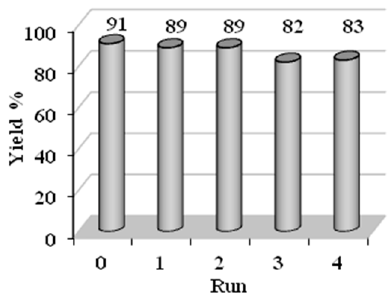
Figure 1. Recycling reactions.